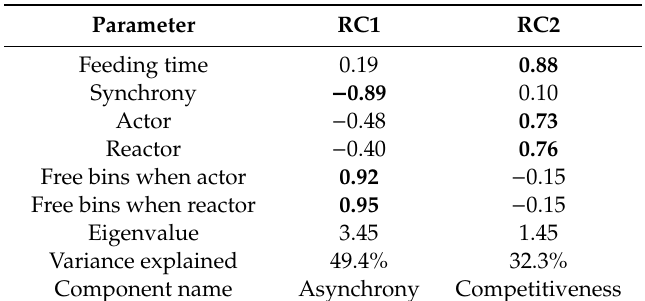
Table 2. Loadings matrix of the Principal Component Analysis performed on behavioral measures in the prepartum period, derived from electronic feeders. Eigenvalues and proportions of total variation explained by each component (RC) are reported. Components were named based on loadings > 0.70, indicated with